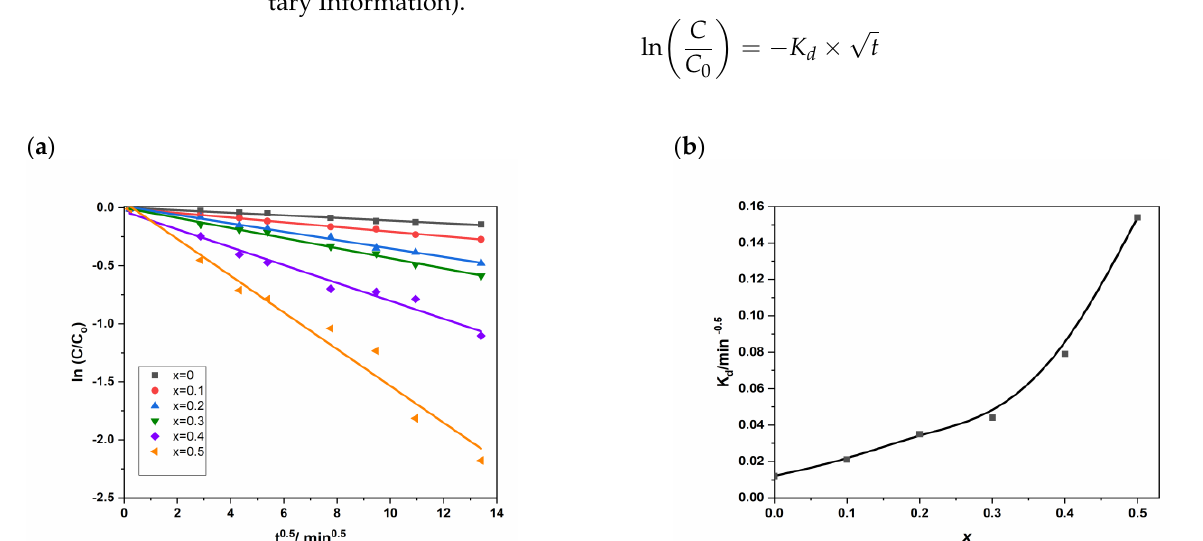
Figure 10. ( a ) ln(C/C0) for different as a function t1/2 and ( b ) Kd vs. cadmium coordination in NSFs.